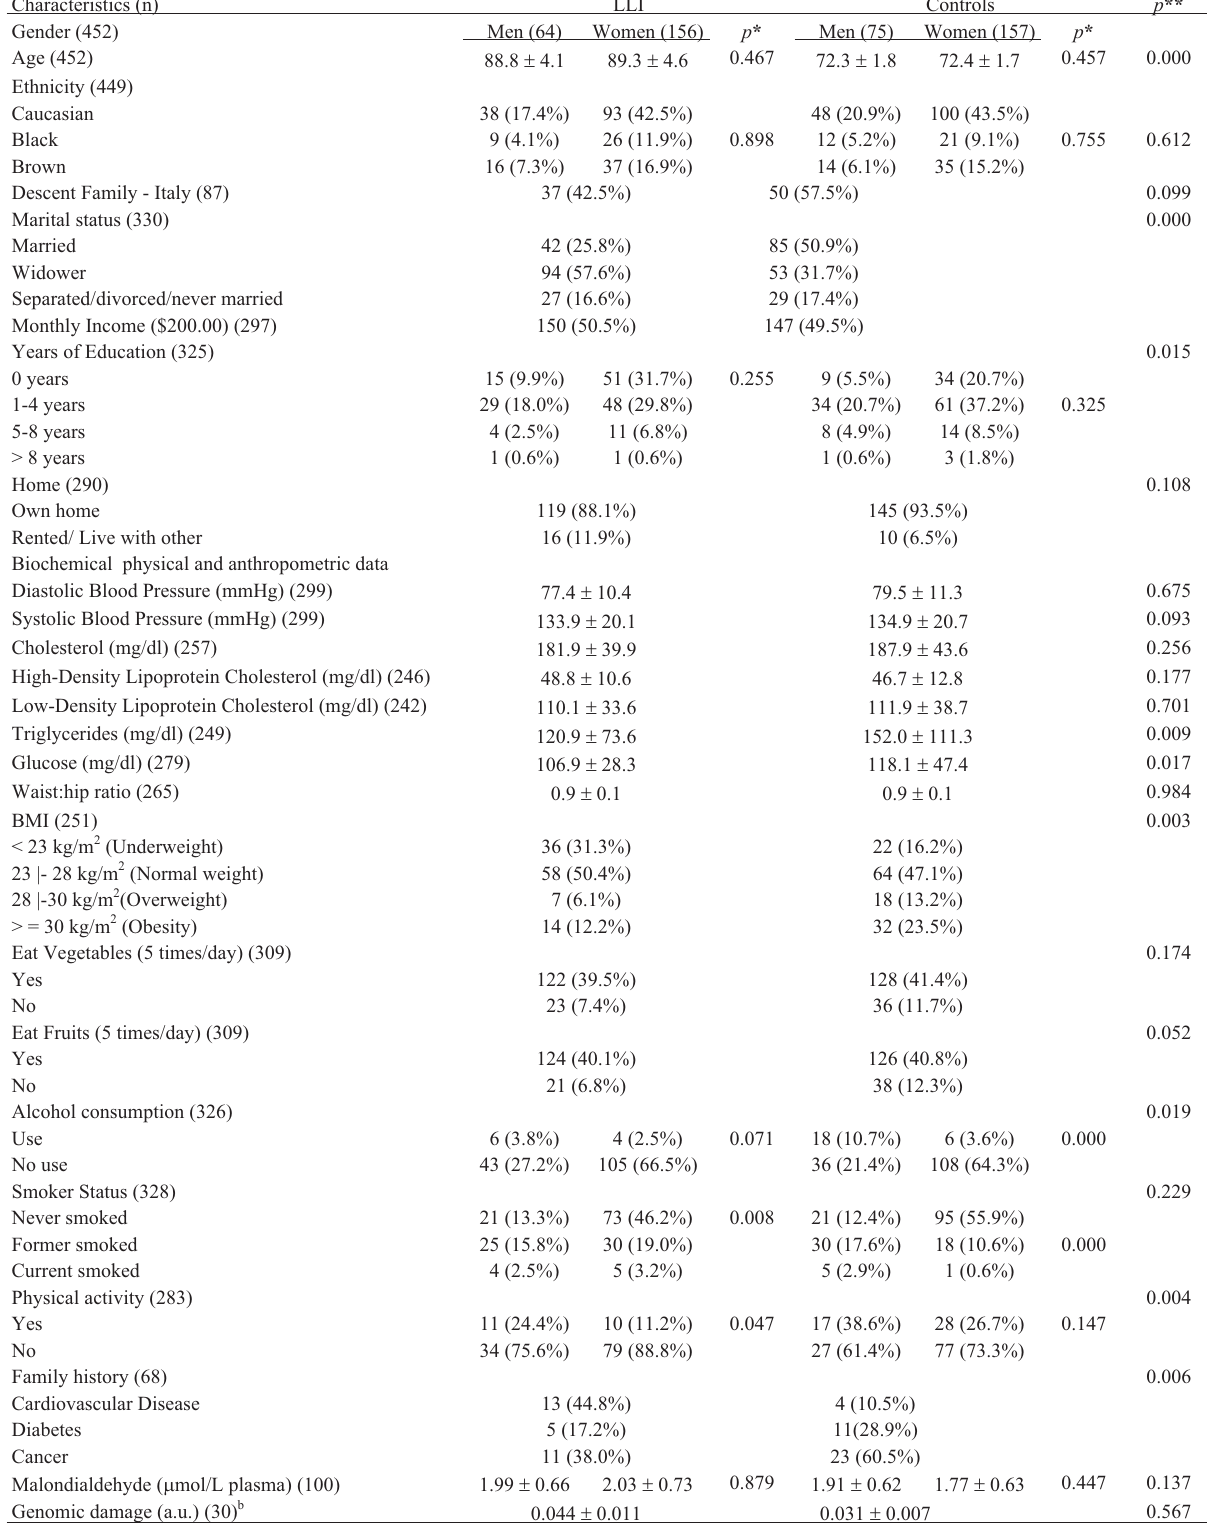
Table 1 - Characteristics of study